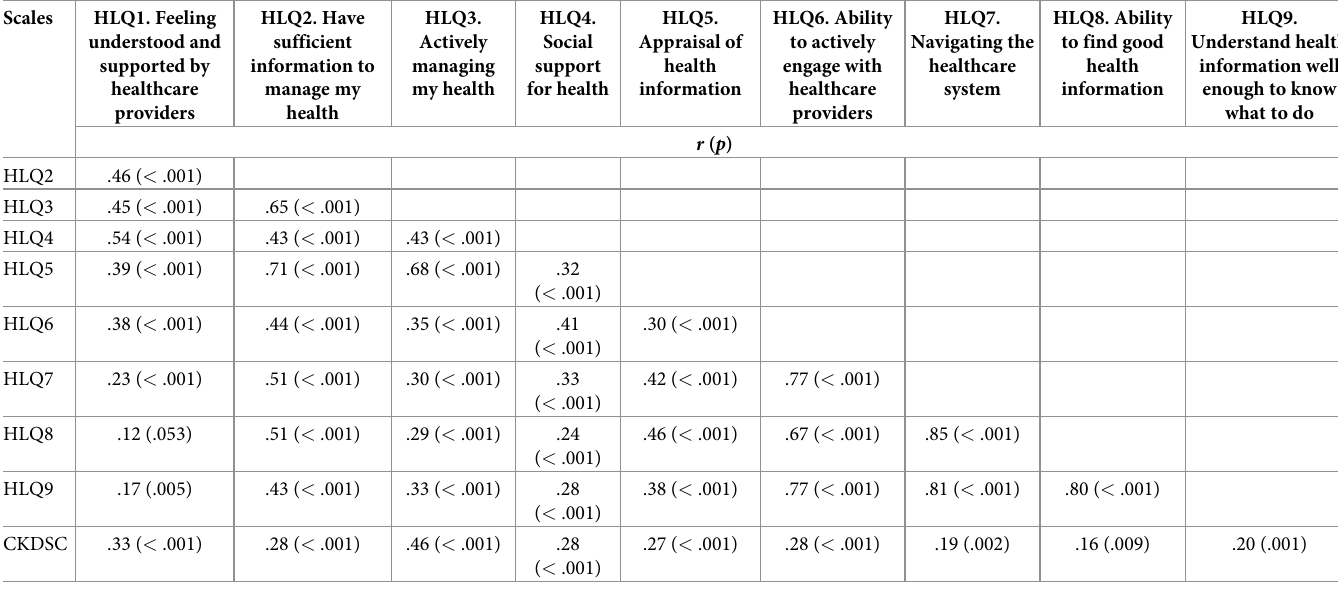
Table 4. Correlations between nine scales of HLQ a and CKDSC b (N = 278). Scales HLQ1. Feeling understood